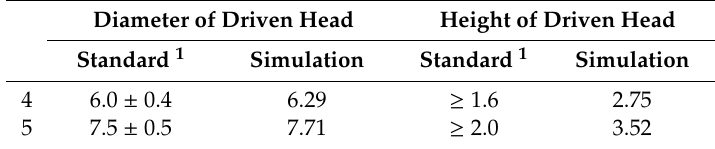
Figure 10. Contours of strains of the rivets after riveting: ( a ) radial strain of the rivet with 4 mm diameter; ( b ) axial strain of the rivet with 4 mm diameter; ( c ) radial strain of the rivet with 5 mm diameter; ( d ) axial strain of the rivet with 5 mm diameter. (unit: mm). Table 3. The driven head dimensions obtained from simulation results (unit: mm).